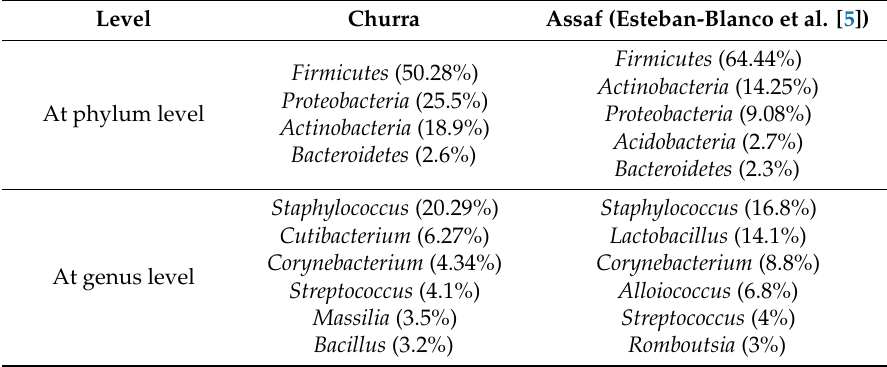
Table 1. Relative microbial abundances for the top-most abundant phyla and genera identified through 16S rRNA gene sequencing in the milk samples of the two sheep breeds studied in this work, Churra and Assaf.